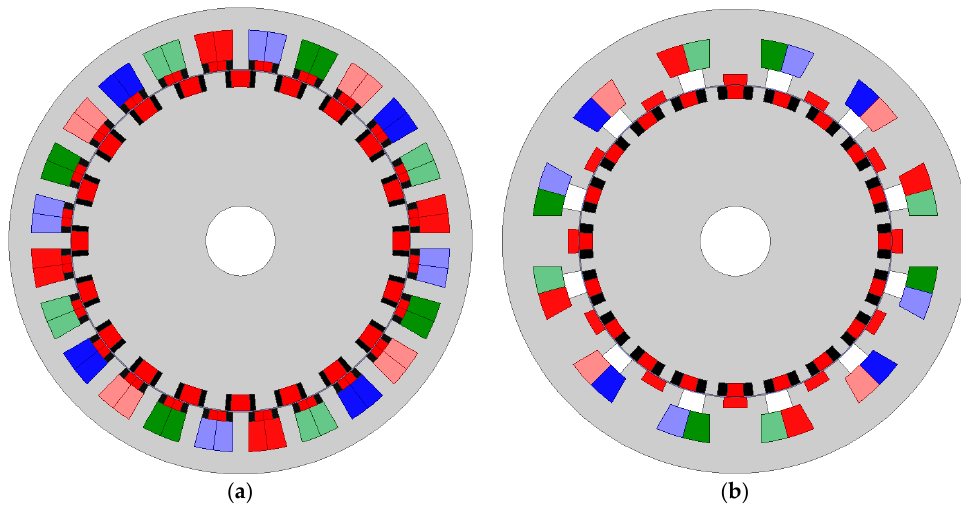
Figure 17. Topologies of two dual-PM machines. ( a ) 24S20R4Pa SSDPM machine; ( b ) 12S20R4Pa STDPM machine.